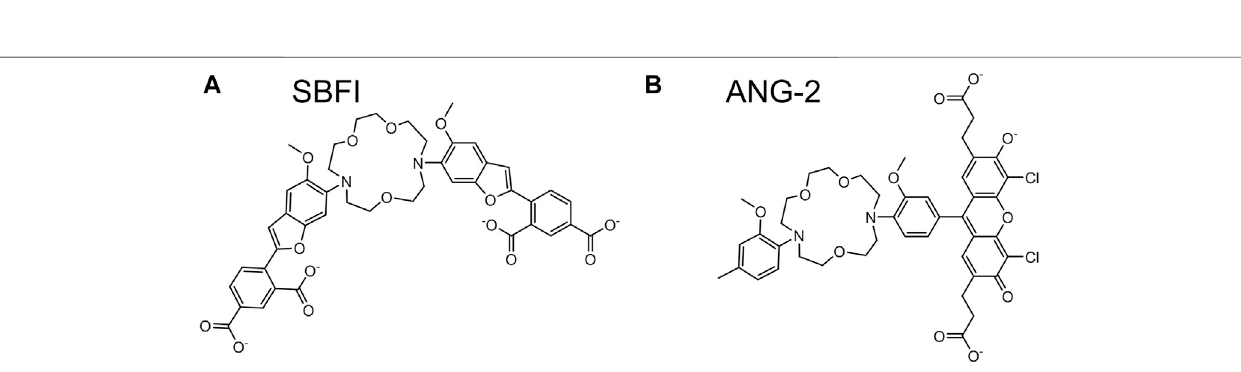
FIGURE 7 | Molecular structures of selected small molecule-based Na + indicators. Small molecule-based Na + indicators differ from K + indicators with respect to their crown ether moieties. Na + indicators are typically based on 1, 7-diaza-4, 10, 13-trioxacyclopentadecane as represented for (A) SBFI and (B) ANG-2 (Minta and Tsien, 1989; Roder and Hille,